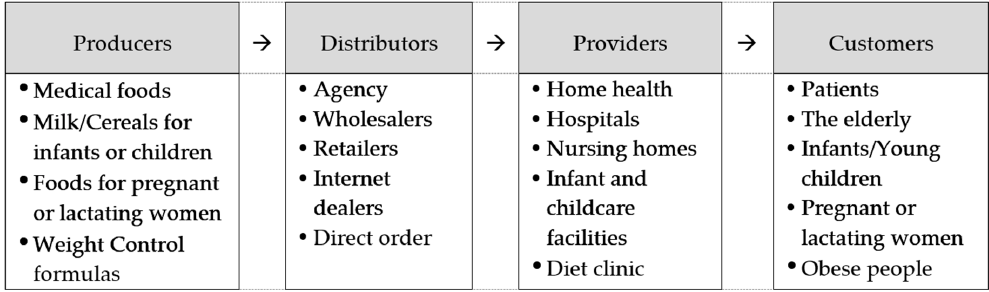
Figure 1. Industrial value chain of foods for special dietary uses.